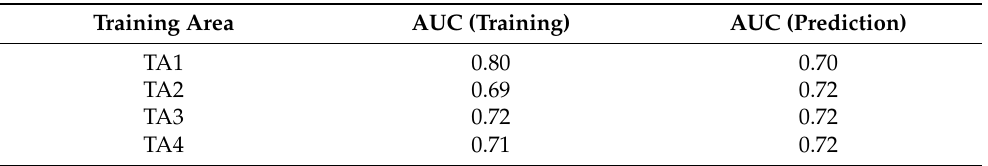
Table 6. Results of the validation of susceptibility models generated with 6 years of burned areas, level 2 COS2018 land use classification and different training areas.